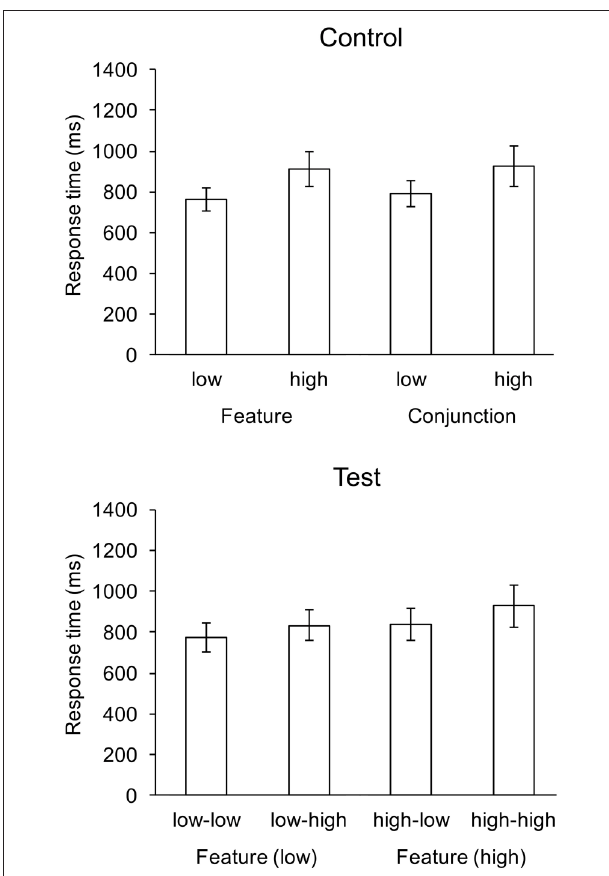
FIGURE 4 | Mean response times (ms) for control and test conditions of the replication experiment. Whiskers indicate one standard deviation.